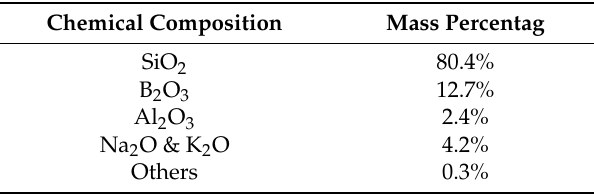
Table 3. Compositions of high borosilicate glass 3.3.